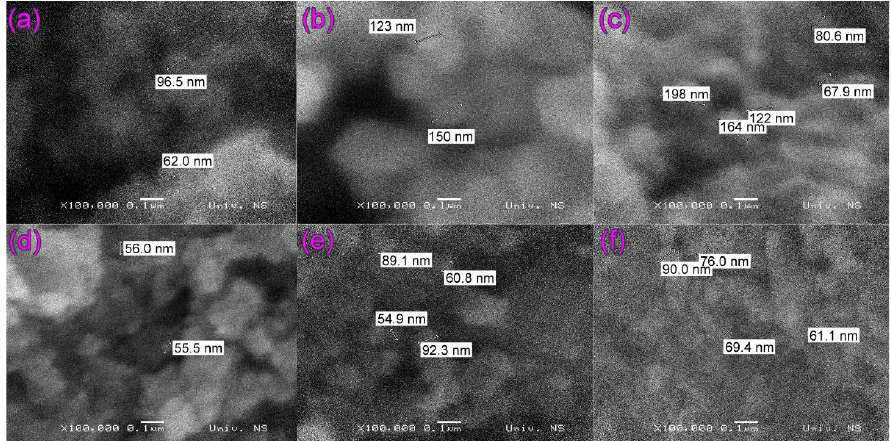
Figure 1. SEM images of particles: ( a ) Fe 3 O 4 and ( b ) ZrO 2 , as well as synthesized nanopowders: ( c ) 0.9ZrO 2 /Fe 3 O 4 ; ( d ) 3.5ZrO 2 /Fe 3 O 4 ; ( e ) 12ZrO 2 /Fe 3 O 4 and ( f ) 19ZrO 2 /Fe 3 O 4 . Line bar 0.1 µ m.